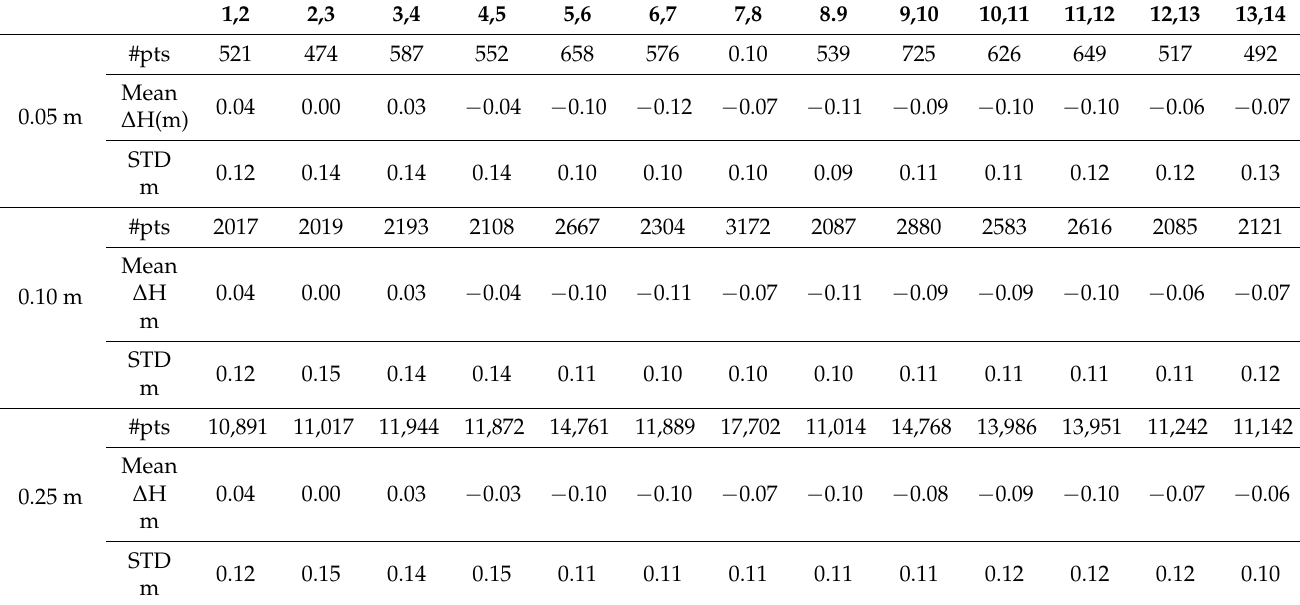
Table 1. Relative height discrepancy between adjacent data